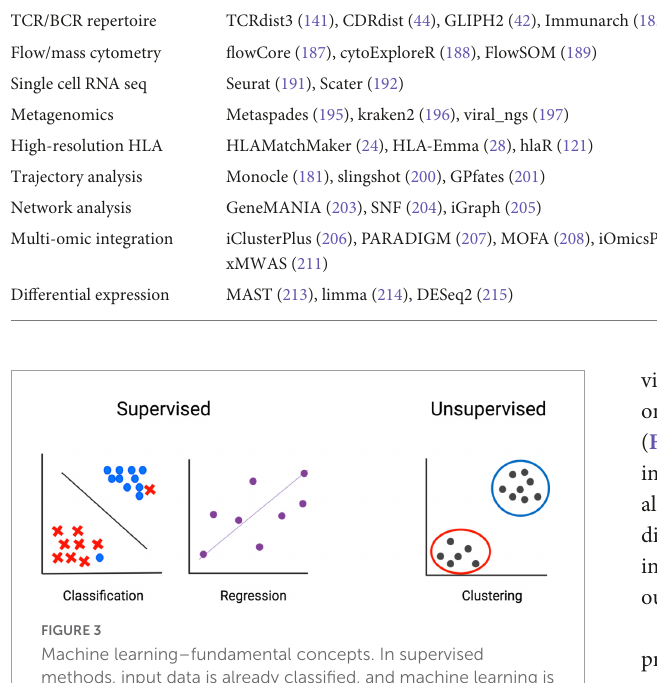
TABLE 1 Bioinformatics tools and review articles for some of the key aspects of systems immunology that are most relevant to transplantation. Analysis